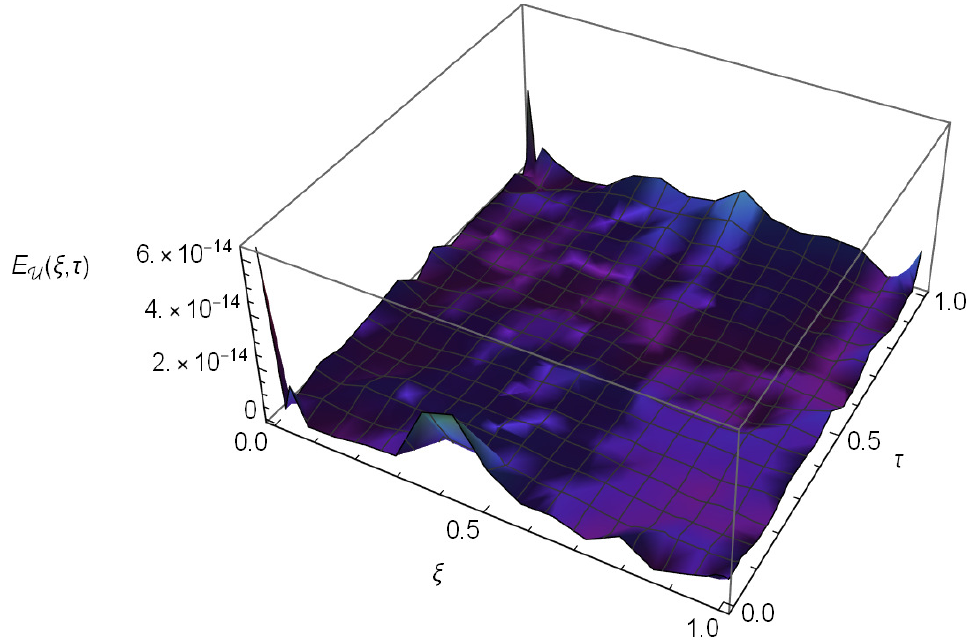
Figure 2. Absolute errors graph of the problem (30), where σ 1 = (cid:36) 1 = σ 2 = (cid:36) 2 = 0, ν = 0.5 and N = M =